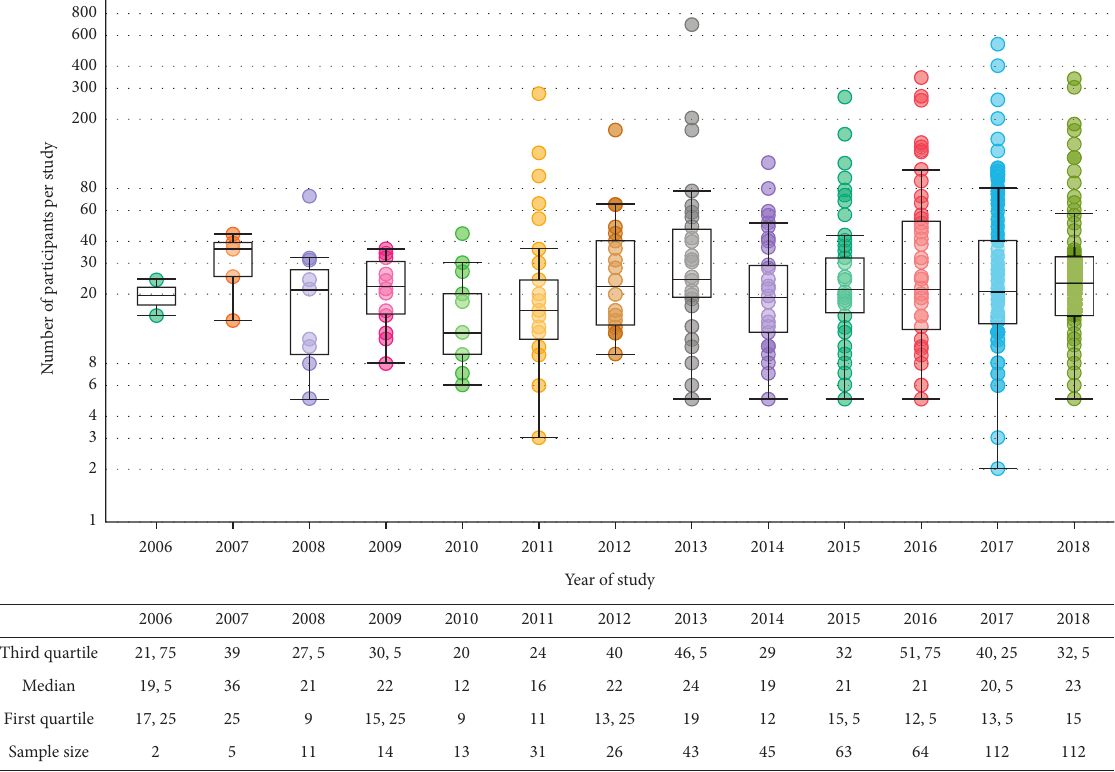
Figure 5: Number of participants per study per year.